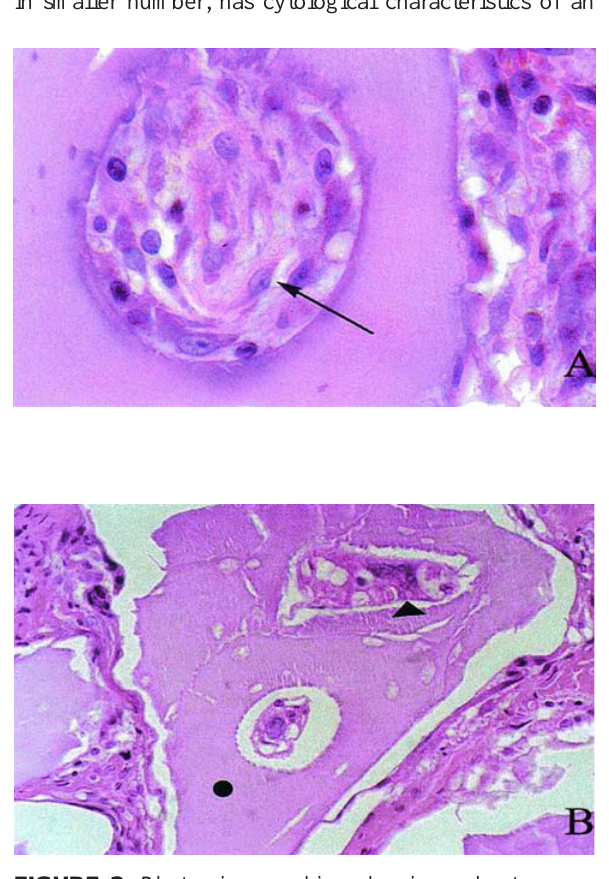
FIGURE 2- Photomicrographies showing subcutaneous tissue response to xenogenic bone graft. (A) Tests group at 10 days showing cells in the interior of the particle pores (arrow).(B) Test group at 20 days it is possible to observe the intimate contact of IMGCs ( ) with the implanted particle surface ( (cid:122) ). Magnifications: x100 (A) and x40 (B), Hematoxylin and